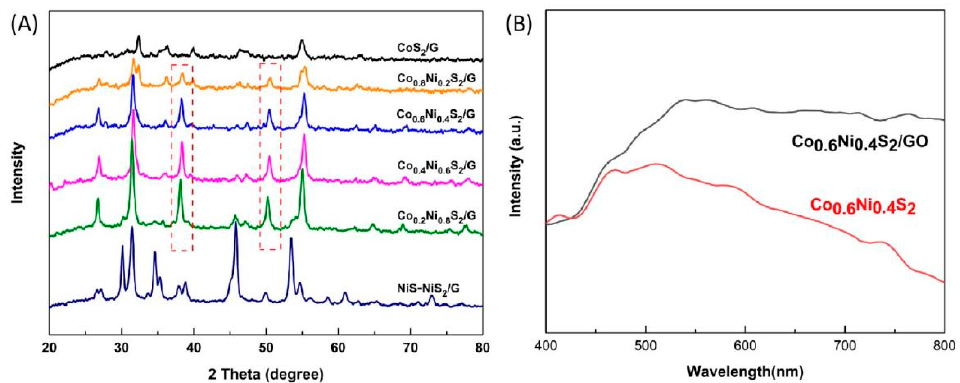
Figure 2. XRD pattern of Co x Ni 1 − x S 2 /rGO (x = 0, 0.2, 0.4, 0.6, 0.8 and 1) ( A ), and UV-vis diffuse reflec- tance spectra of Co 0.6 Ni 0.4 S 2 and Co 0.6 Ni 0.4 S 2 /rGO samples ( B ).